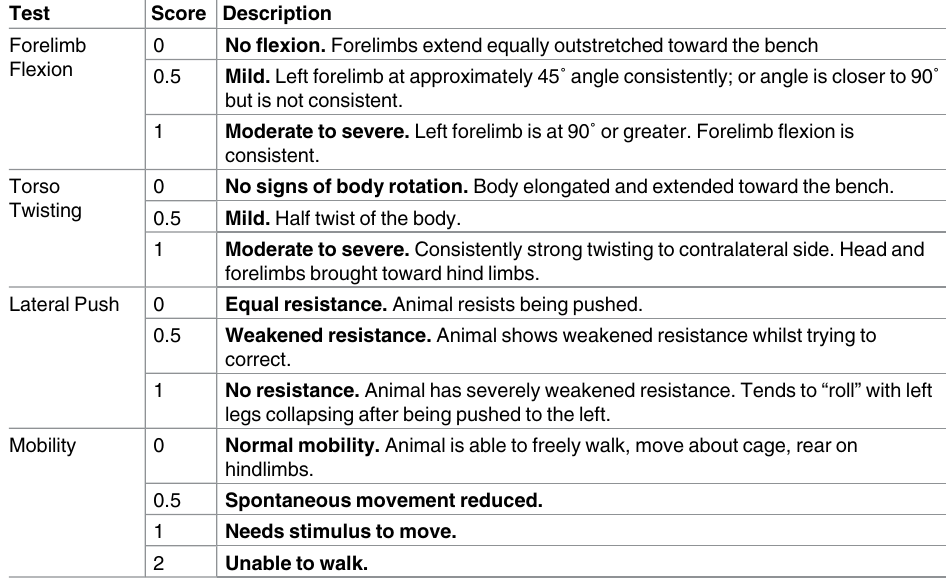
Table 1. Scoring criteria for Basic Behavioural Test after stroke (Modified from Petullo et